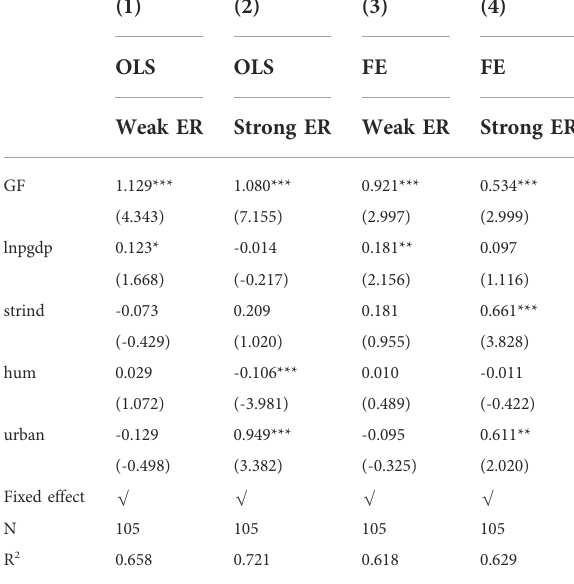
TABLE 7 Heterogeneity effect based on environmental